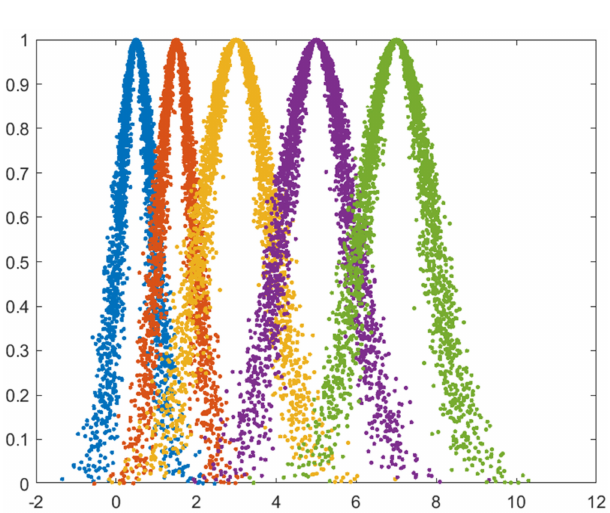
Figure 4. Per capita gross regional product cloud